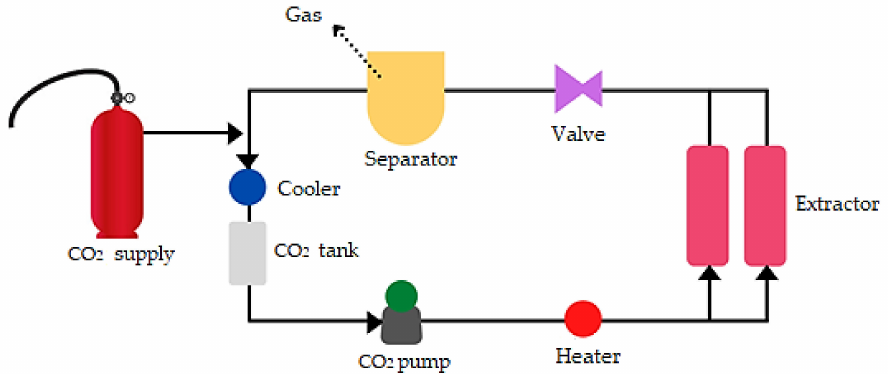
Figure 1. Schematic diagram of the SC-CO 2 extraction system of DPL.